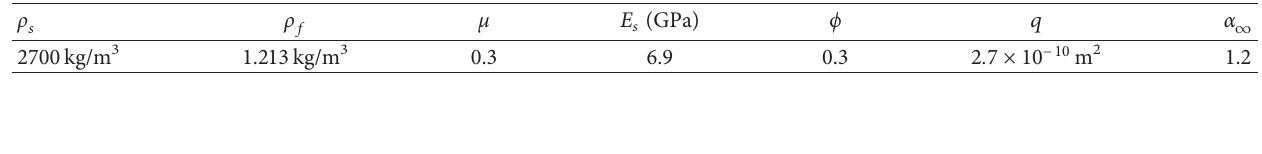
Table 2: Parameters of the rigid framed rotational shell.